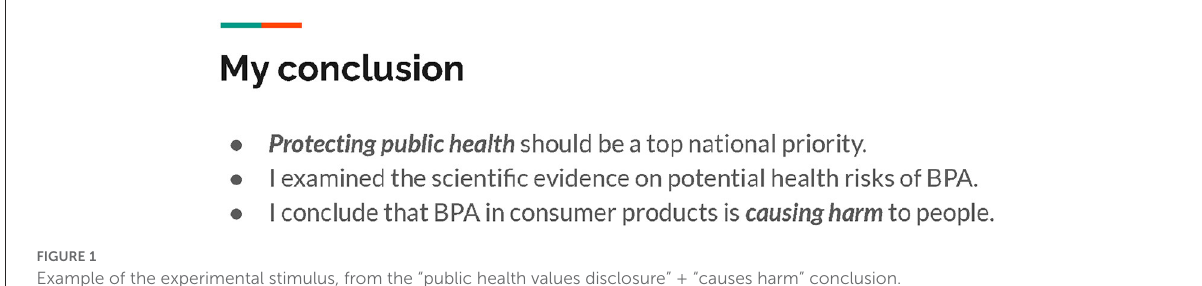
FIGURE1 Example of the experimental stimulus, from the “public health values disclosure” + “causes harm” conclusion.